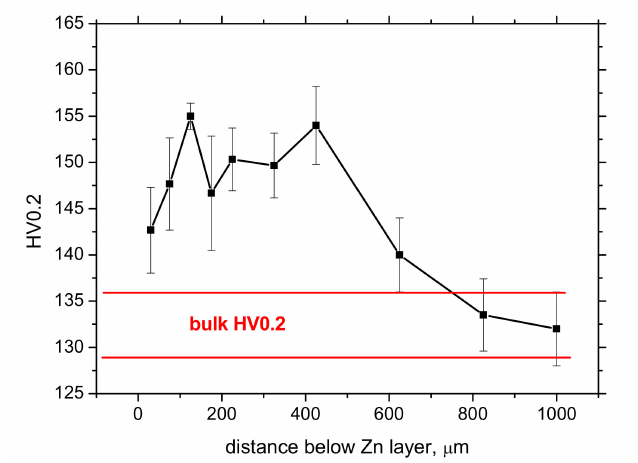
Figure 8. Microhardness profile HV0.2 below the Zn layer. Zero distance represents the boundary between the Zn layer and the